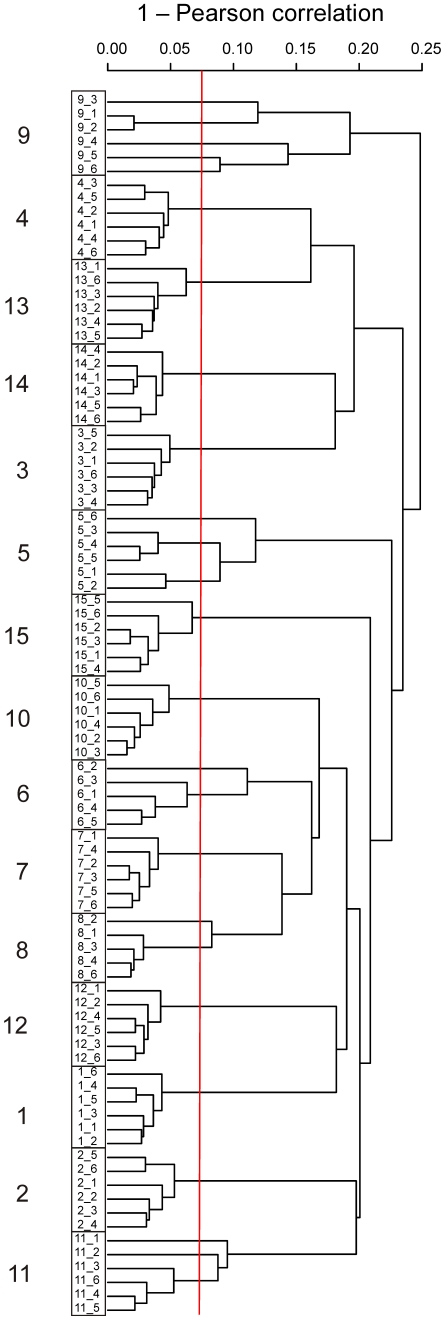
Hierarchical clustering of the HITChip profiles of 15 subjects and their six timepoints.The subject-wise clustering is highlighted with boxes and the temporal variation is displayed with the variable length of the branches. Red vertical line is drawn at Pearson correlation of 0.925, below which the intra-individual sample similarity was detected only in the five unstable subjects (5,6,8,9 and 11) discussed in the text.